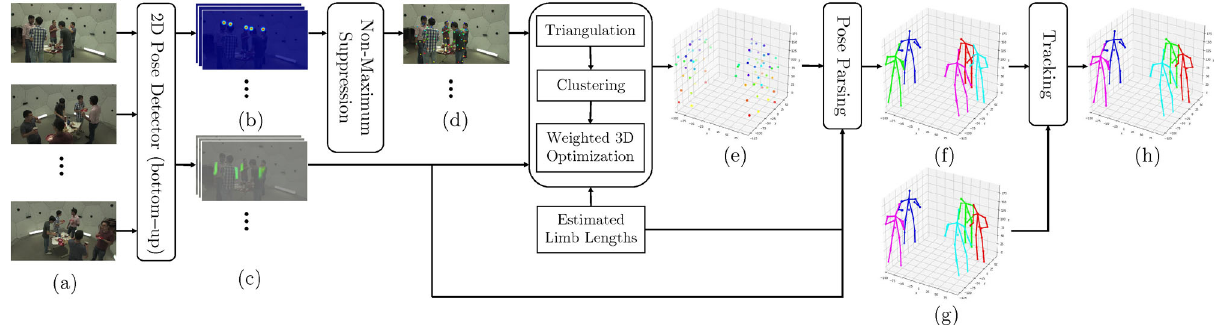
Fig. 2 Overview. The input is a set of synchronized images from multiple views (a); the final output comprises 3D poses in global world space (h). Each individual is followed over time marked with a fixed color as in (g) and